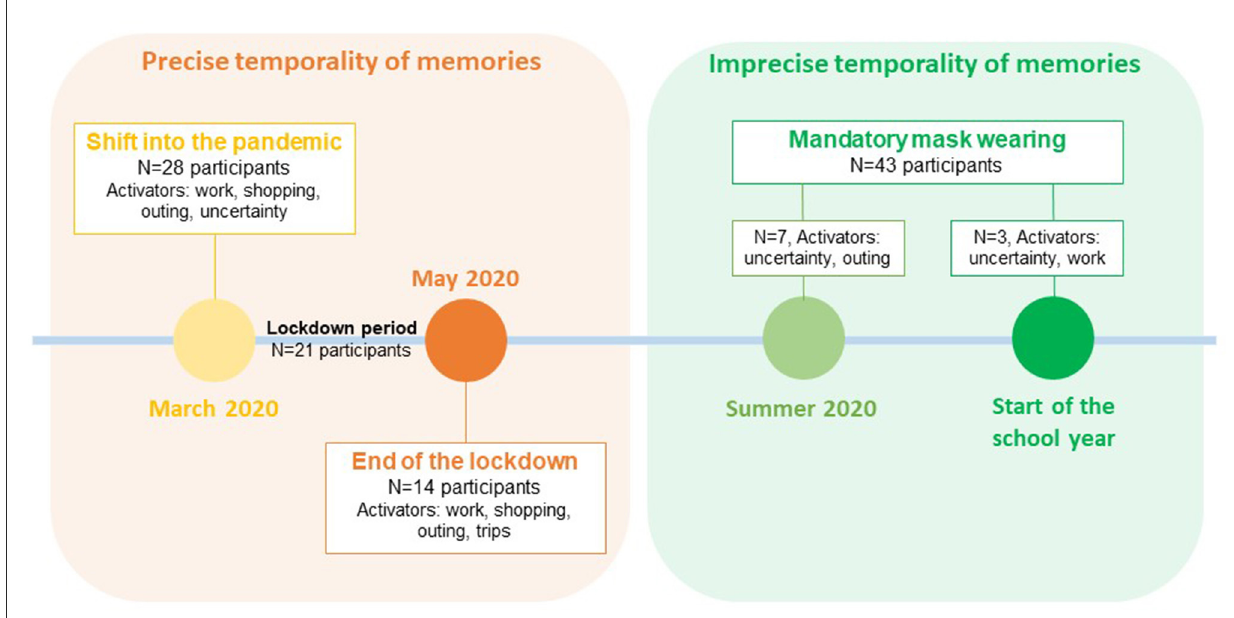
FIGURE2 Sensitivity chronology displaying memory activators according to the period of first masks wearing. The number in each black rectangle indicates the number of interviewees who shared this time representation.